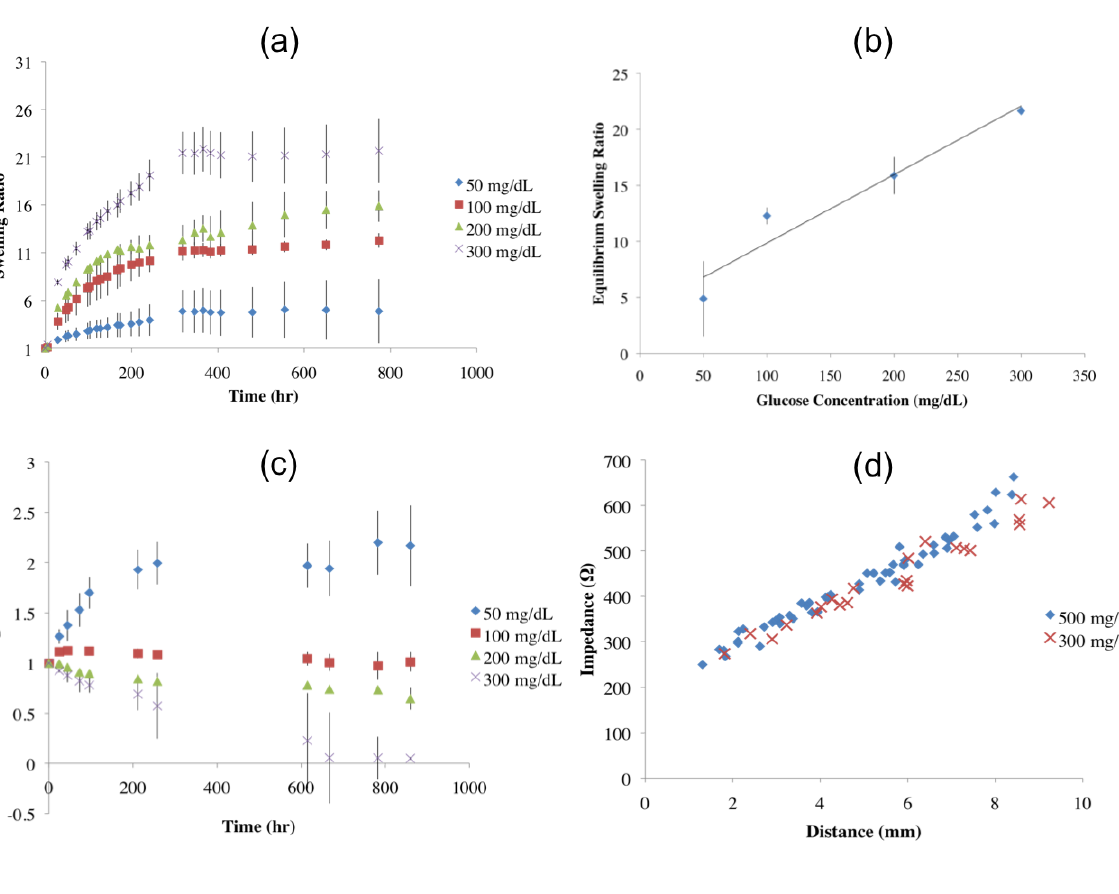
Figure 1. (a) Swelling ratio versus time for hydrogel samples that were exposed to glucose solutions of 50, 100, 200, and 300 mg/dL after initially being placed in 0 mg/dL glucose solution. Equilibrium was reached after approximately 300 h. (b) Equilibrium swelling ratio of the hydrogels versus glucose concentration of exposure. (c) Swelling ratio versus time of hydrogels that had reached equilibrium swelling ratios in 50, 100, 200, and 300 mg/dL glucose solutions and then transferred to a glucose solution with a glucose concentration of 100 mg/dL. (d) Impedance versus distance through hydrogels that were exposed to 300 and 500 mg/dL glucose